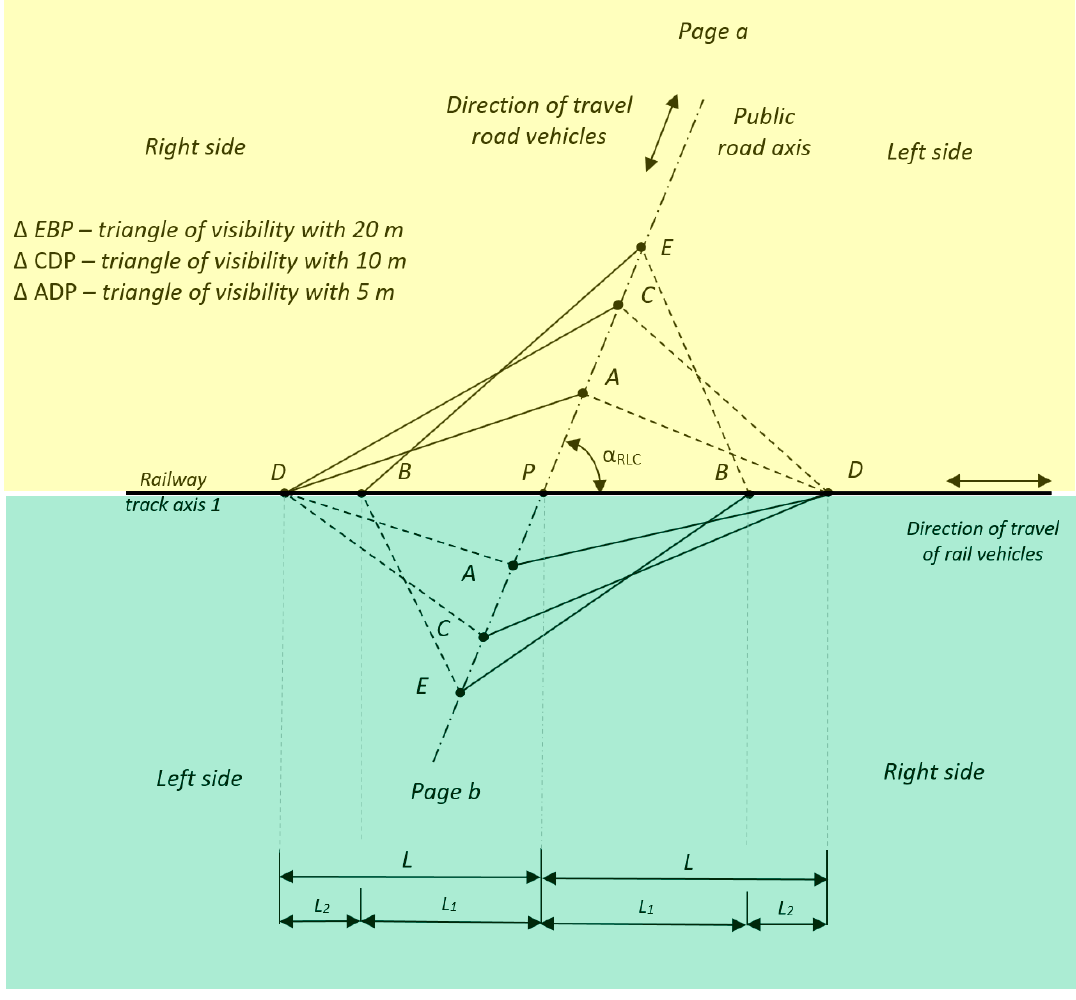
Figure 2. Surveying of visibility triangles.